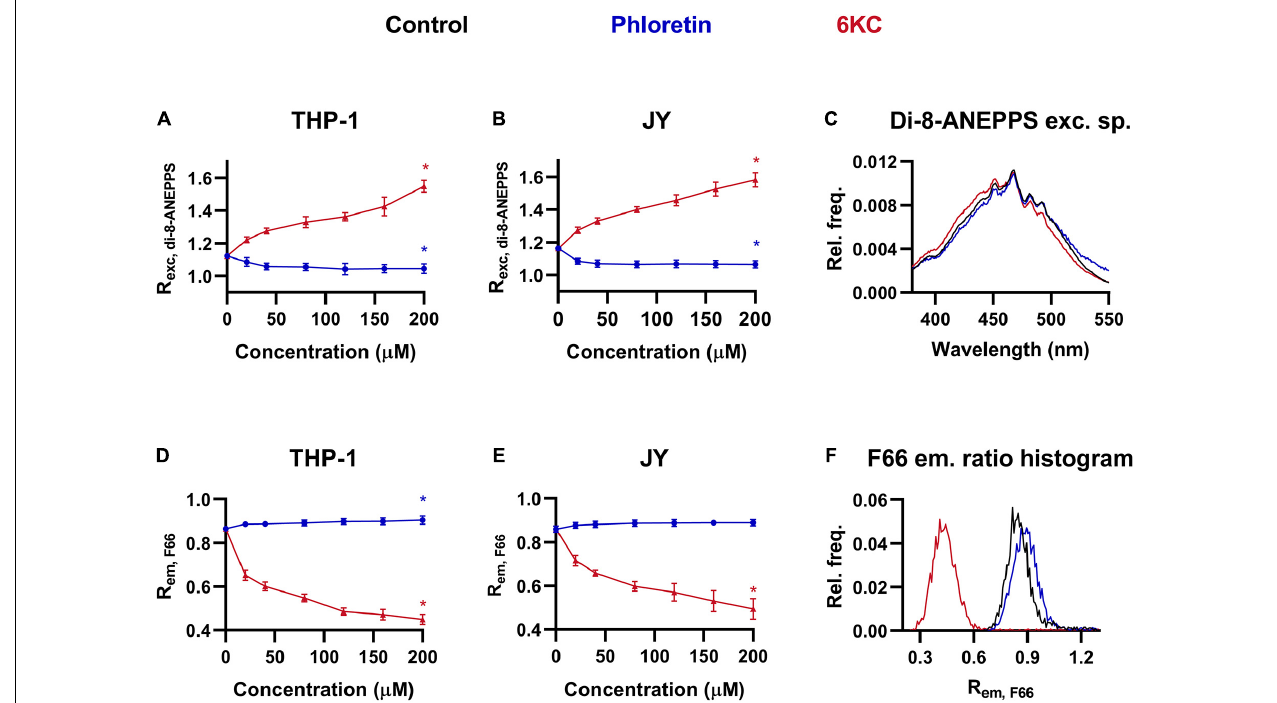
FIGURE 1 | Effects of phloretin and 6-ketocholestanol (6KC) on the magnitude of dipole potential. THP-1 (A) or JY cells (B) were treated with phloretin or 6KC at various concentrations between 20 and 200 µ M and labeled with di-8-ANEPPS followed by determination of the dipole potential-sensitive excitation ratio (R exc , di − 8 − ANEPPS ) using spectrofluorometry. R exc , di − 8 − ANEPPS values were calculated from fluorescence intensities integrated between excitation wavelengths 410–440 nm and 490–520 nm and the mean ( ± SD) values of five independent experiments were plotted as a function of the applied concentrations of phloretin (dark blue) and 6KC (red). Representative excitation spectra display shifts induced by phloretin and 6KC compared to controls (black) (C) . Alternatively, control THP-1 (D) or JY (E) cells and those treated with phloretin or 6KC were labeled with F66 and the emitted fluorescence intensities of individual cells were measured in the wavelength ranges 470–490 nm and 564–606 nm and the mean intensity ratio (R em , F 66 ) was calculated from data of at least 20,000 living cells per sample. The average values of five independent measurements ( ± SD) were plotted as a function of the applied concentrations of phloretin and 6KC. Representative histograms containing data of individual cells display the shifts in R em , F 66 values in response to phloretin and 6KC compared to controls (F) . Asterisks (*) indicate significant differences obtained at maximal treatment concentrations compared to control samples ( p < 0.05, ANOVA followed by Tukey’s HSD test).